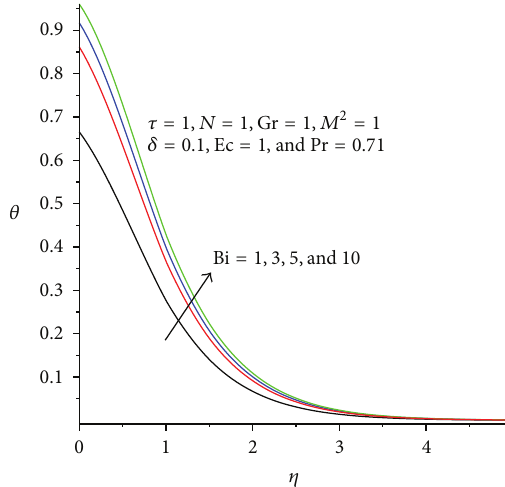
Figure 11: Temperature profiles with increasing time.